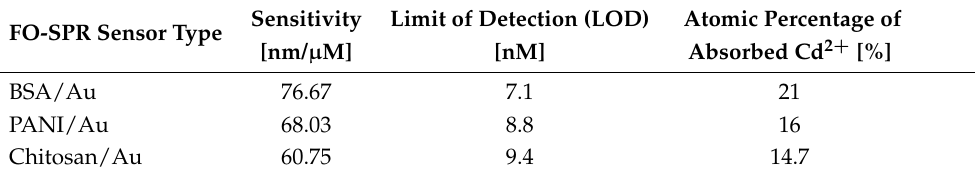
Table 1. Performance comparison between the three differently prepared FO-SPR